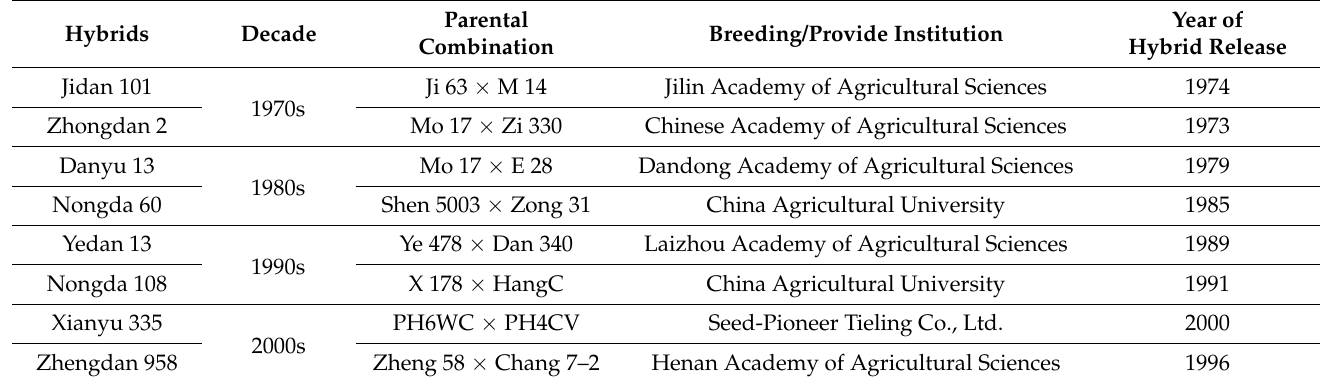
Table 1. Details of the maize hybrids used in different